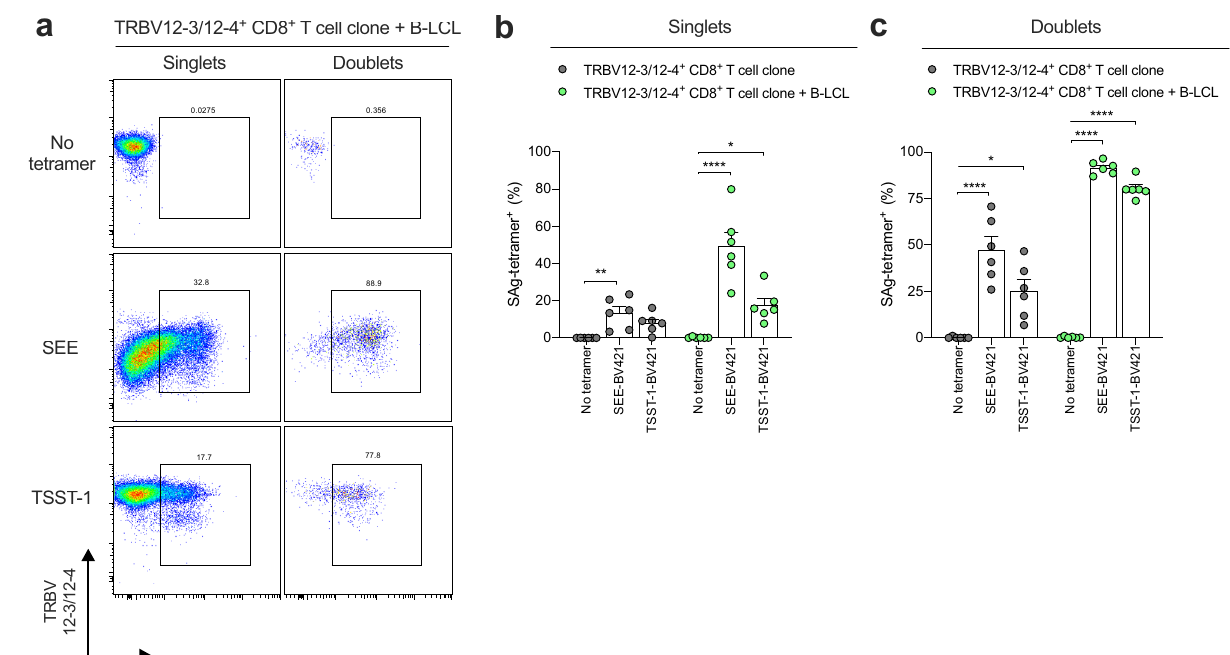
Fig. 6 TSST-1 interacts with clonal CD8 + T cells expressing TRBV12-3/12-4 + TCRs. a Representative fl ow cytometry plots showing the frequency of SEE or TSST-1 tetramer + events among clonal TRBV12-3/12-4 + CD8 + T cells cultured at a 1:1 ratio with the MR B-LCL. Plots are gated on live singlets (left) or doublets (right). b , c Frequency of SEE or TSST-1 tetramer + events among clonal TRBV12-3/12-4 + CD8 + T cells gated as singlets ( b ) or doublets ( c ) in the absence (dark gray fi lled circles) or presence of the MR B-LCL (green fi lled circles). Each dot represents one experiment. Data are shown as mean ± SEM. * p < 0.05, ** p < 0.01, **** p < 0.0001. One-way ANOVA with Tukey ’ s post-hoc